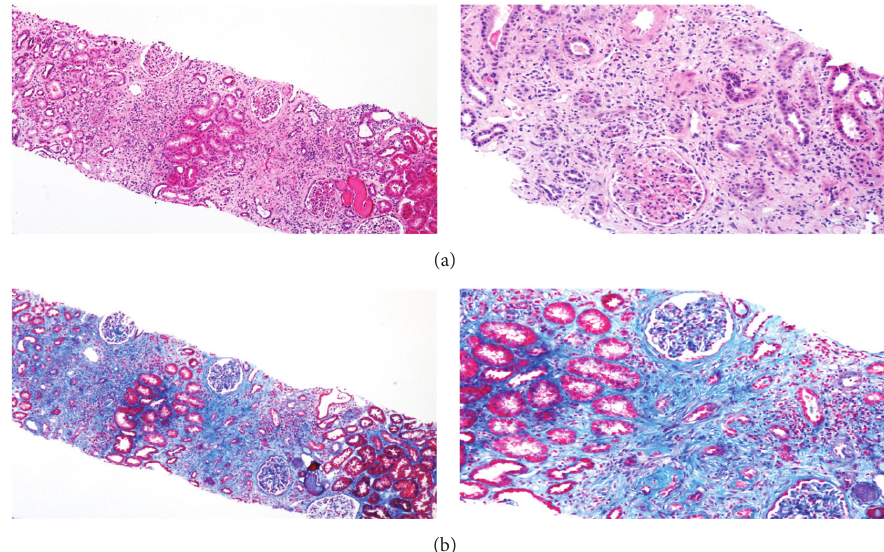
Figure1:Lightmicroscopicexaminationofthekidneybiopsyshowingseverecorticalinterstitialfibrosisandtubularatrophy,acuteinterstitial nephritis with prominent mononuclear cellular infiltrate, and multifocal tubulitis ((a) H&E 4x, 10x; (b) Masson Trichrome 4x, 10x).